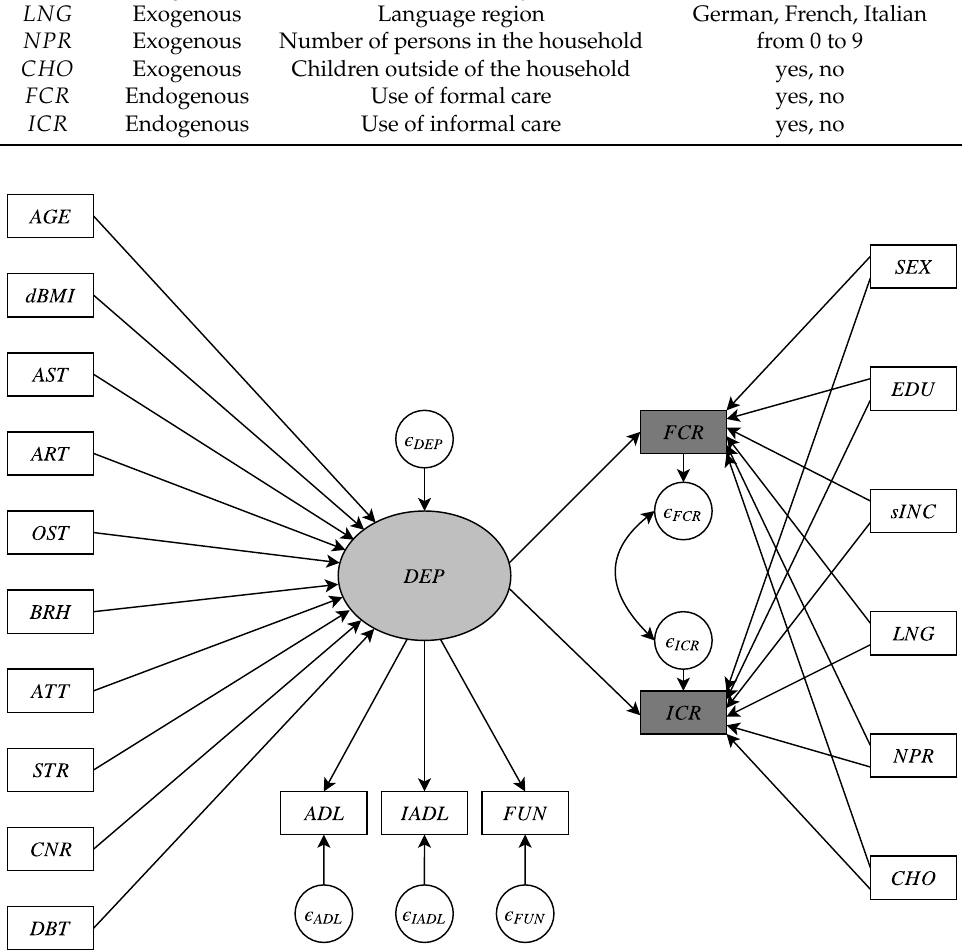
Figure 1. Graphical representation of the proposed structural equation model